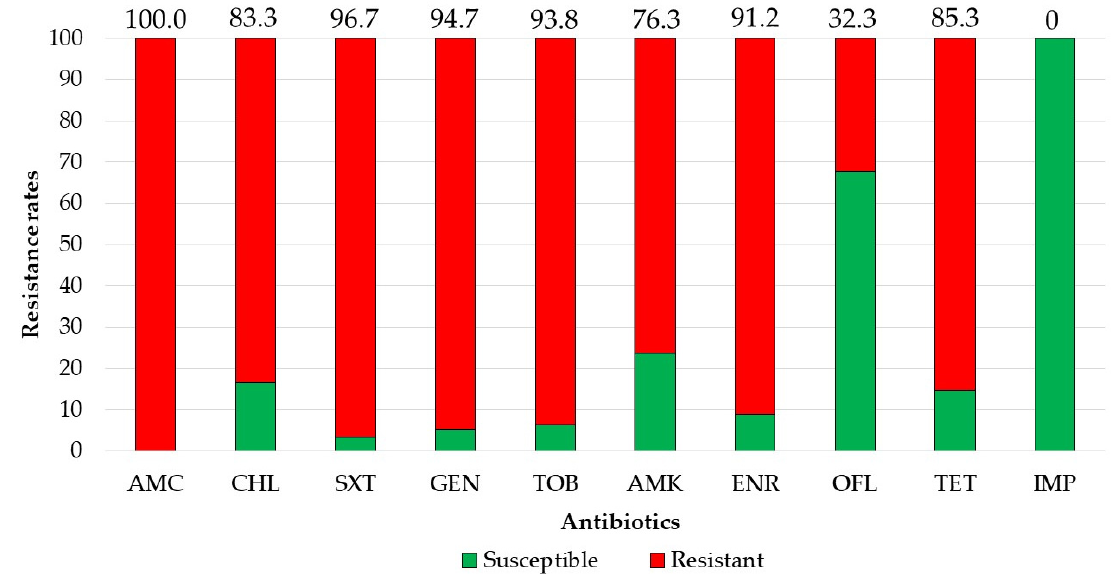
Figure 3. Resistance rates of 3GCRE pathogens ( n = 39) towards commonly prescribed agents. AMC, amoxicillin-clavulonate; CHL, chloramphenicol; SXT, trimethoprim-sulfamethoxazole; GEN, gentamicin; TOB, tobramycin; AMK, amikacin; ENR, enrofloxacin; OFL, ofloxacin; TET, tetracycline; IMP, imipenem.